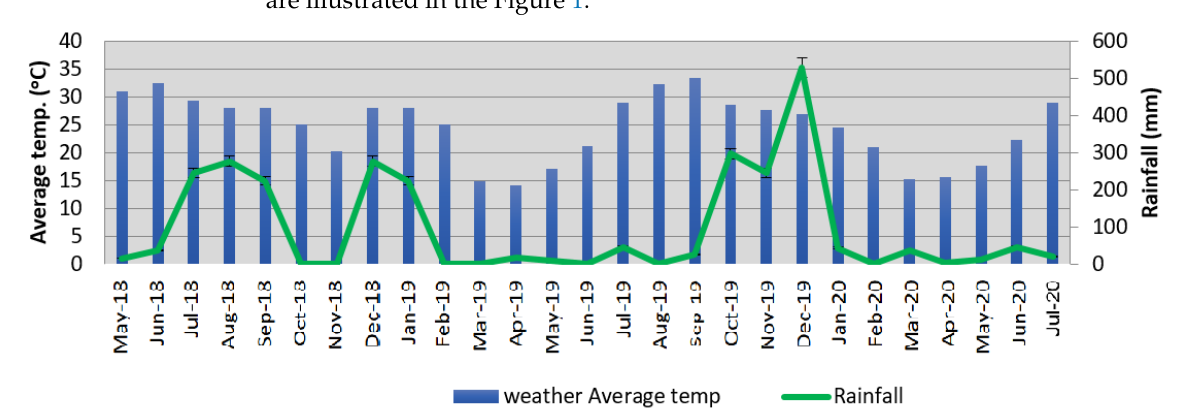
Figure 1. Weather condition of experimental field.